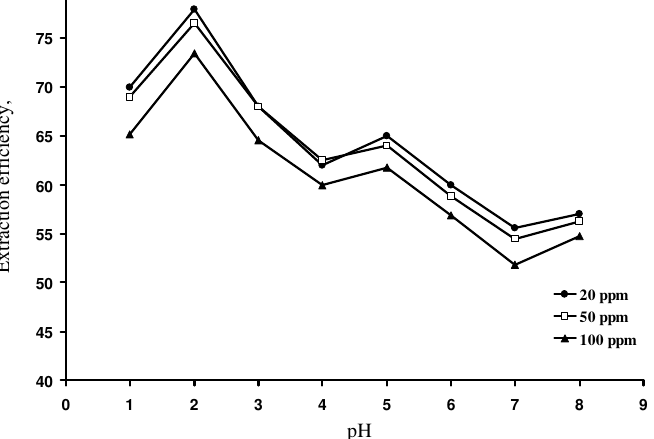
Figure 2. Effect of pH on removal of reactive black 5 ( Conditions: 50 mL of solution containing different concentration of dye (20, 50 and 100 ppm), 0.4 M of NaCl and 0.12 M of triton x-100, equilibration temp 65 o C and equilibration time 30 min, centrifuge time 10 min and centrifuge rates 3500 rpm